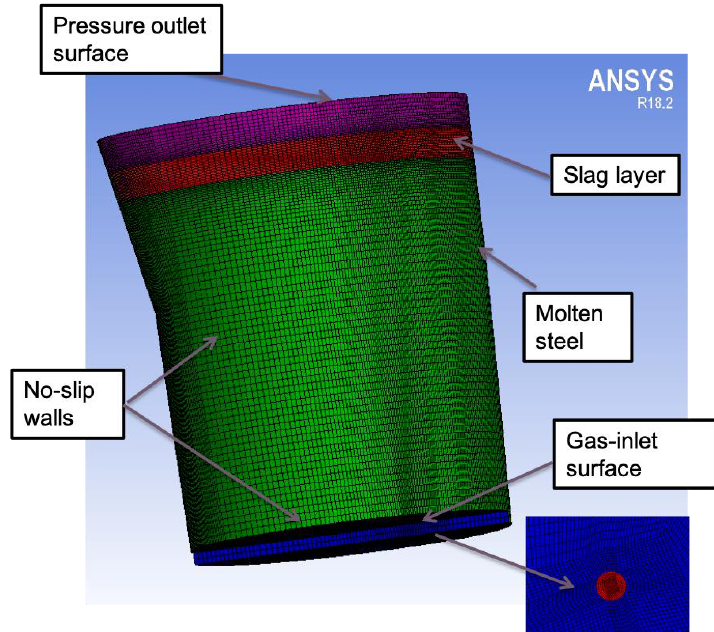
Figure 1. Computational domain and mesh system of the industrial scale ladle.